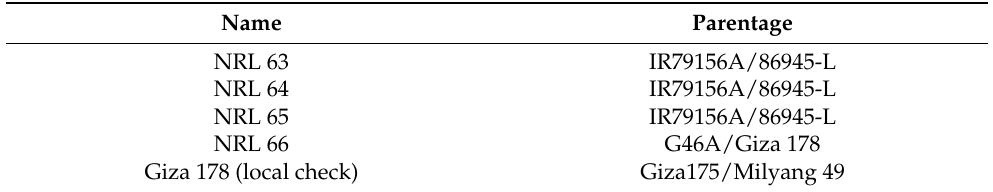
Table 1. Names and parentage of the genotypes